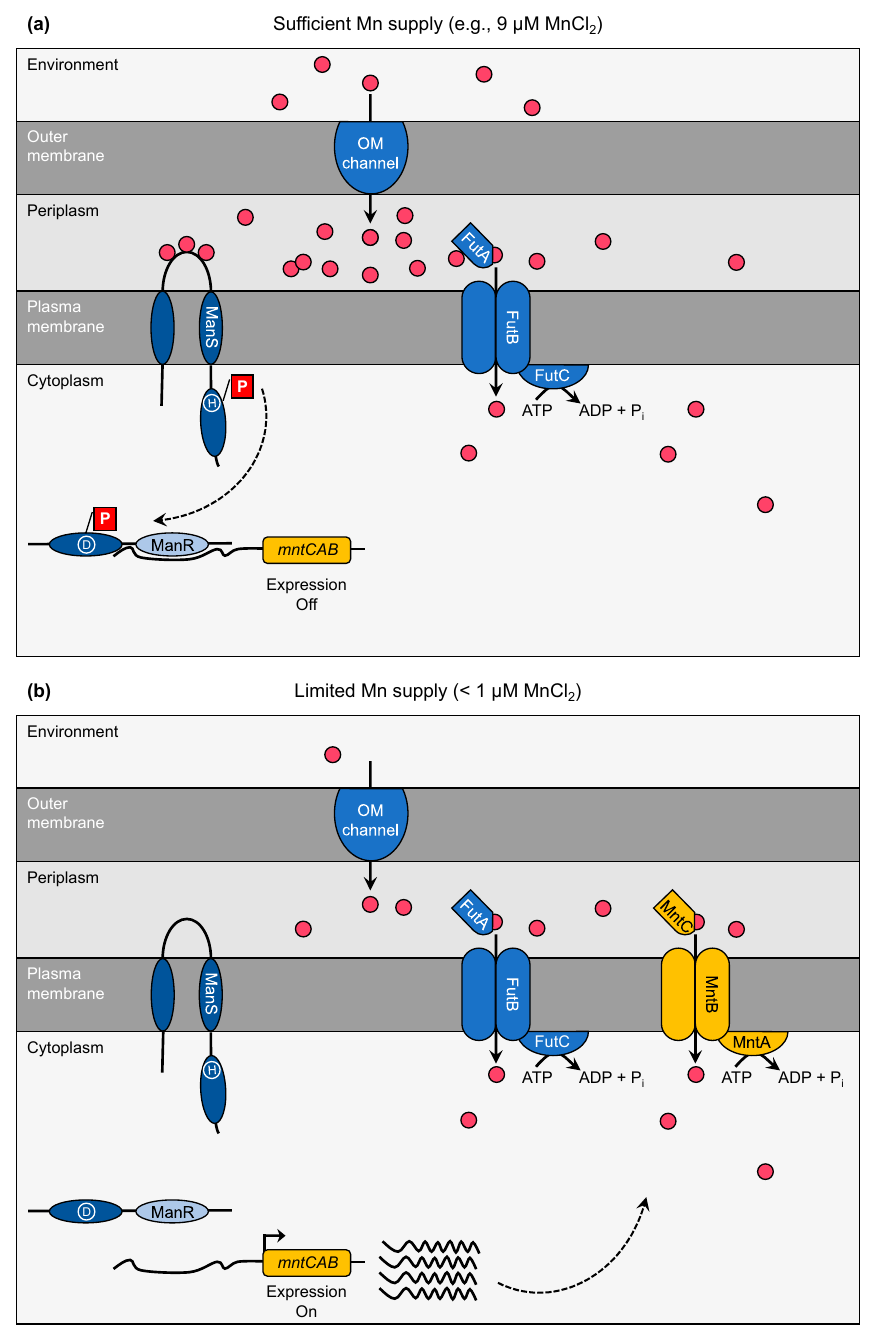
Figure 2. Model for the Mn-dependent operating mode of the ManS / ManR two-component system in Synechocystis . ( a ) At su ffi cient Mn supply (e.g., 9 µ M MnCl 2 ) the sensor protein ManS binds Mn 2 + -ions (pink-colored circles) in its periplasmic loop domain. This leads to phosphorylation (depicted as red box) of a His residue (encircled H) in its kinase domain. Thus, the activated sensor phosphorylates an Asp residue (encircled D) in the receiver domain of the response regulator ManR, resulting in binding of the DNA-binding domain (light-blue) to the promoter of the mntCAB operon (orange), thus blocking expression. ( b ) Under Mn-limiting conditions ( < 1 µ M MnCl 2 ) ManS is inactive and does not phosphorylate ManR. As a result, expression of the mntCAB operon takes place and leads to assembly of the MntCAB at the plasma membrane to maintain su ffi cient Mn import.